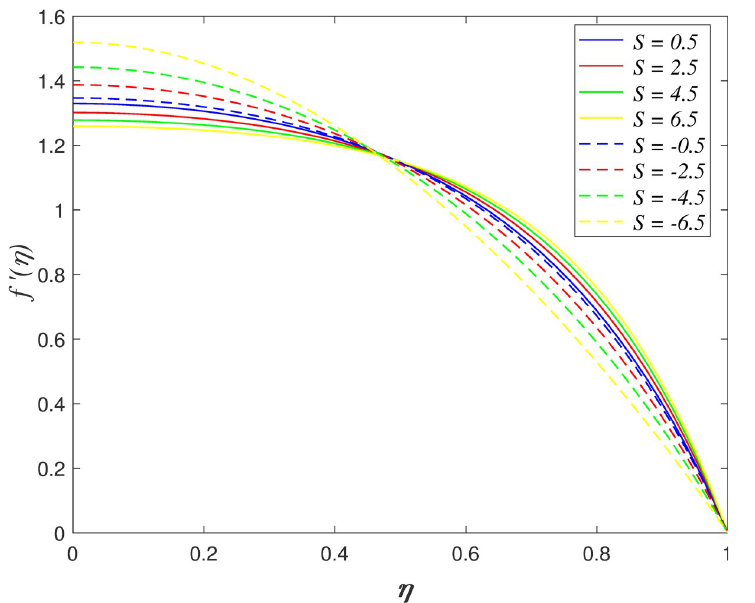
Fig 3. Impact of S on axial